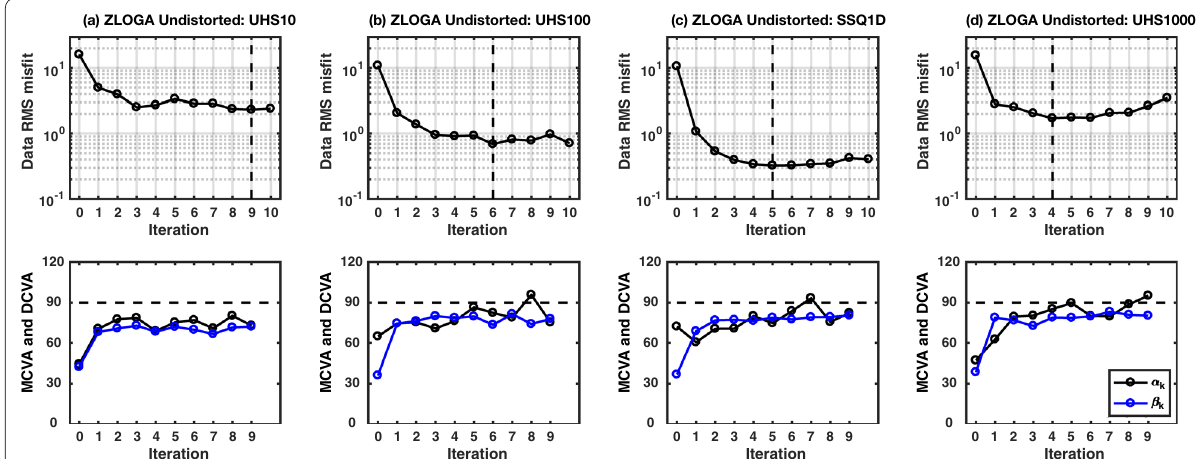
Fig. 17 dRMS (top, black solid curve with symbols) and the MCVA (bottom, black) and DCVA (bottom, blue) at each iteration step obtained from inverting ZLOGA of undistorted impedances using a UHS10, b UHS100, c SSQ1D, and d UHS1000 as the initial model. Dashed lines in the dRMS plots indicate the iteration step, where the dRMS is minimized